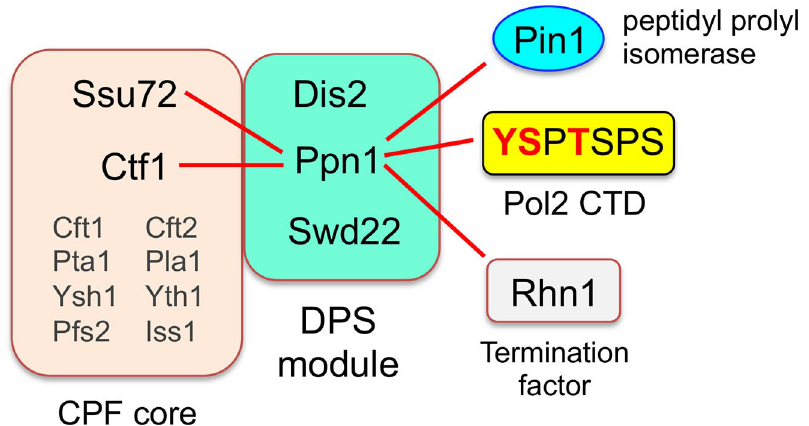
Fig 1. Organization of fission yeast CPF and genetic interactions of its subunits. Essential subunits of the CPF core are shown in gray font; inessential subunits of the core and DPS module are in black font. Synthetic lethalities of ppn1 Δ with mutant alleles of CPF subunits, termination factor Rhn1, Pol2 CTD phospho-site mutants (red font), and prolyl isomerase Pin1 are denoted by red